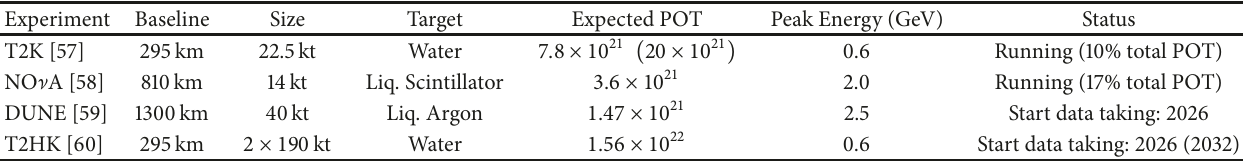
Table 1: Summary of neutrino